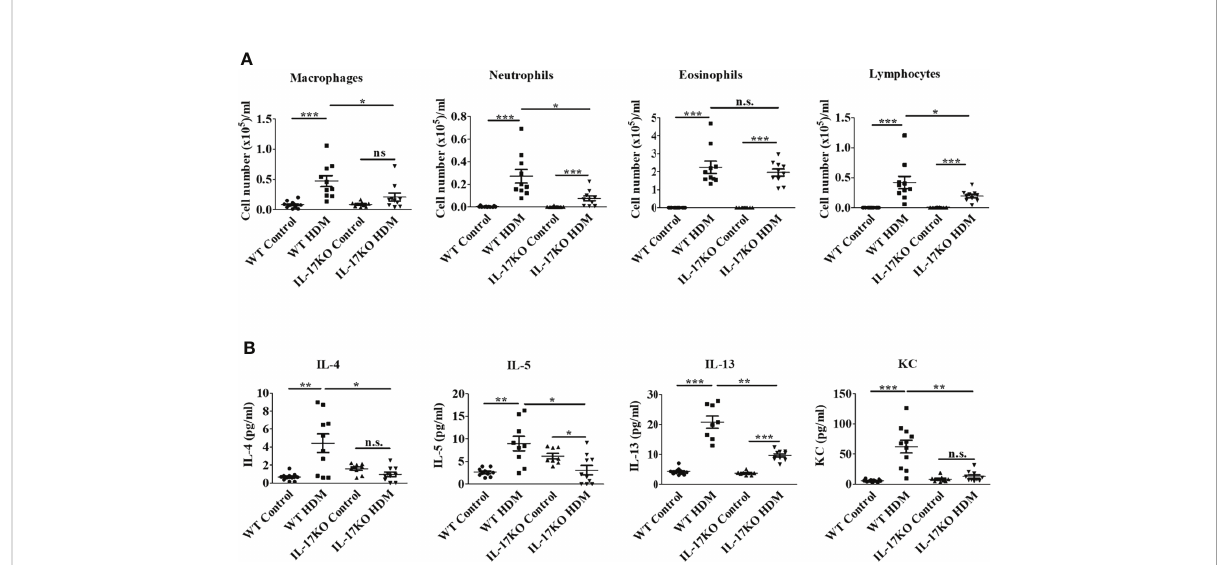
FIGURE 2 Indispensable role of IL-17 in the in fl ammatory response of HDM-induced asthma in murine model. (A) Counts of in fl ammatory cells in BALF. N=10. (B) The level of in fl ammatory cytokines in BALF. The in fl ammatory cytokines in BALF were detected by Bio-Plex. N=10. *, P<0.05, **, P<0.01, ***, P<0.001. n.s., not statistically signi fi